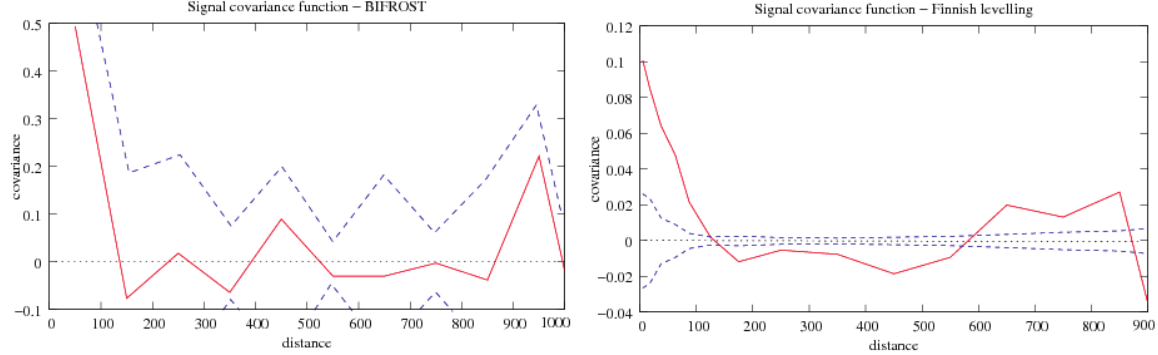
Fig. 5. Signal covariance functions (red, drawn) for tested data sets. Units: 2 (mm/a) . 3 σ bounds for standard deviation (cf. Fig. 6) are drawn in dashed blue